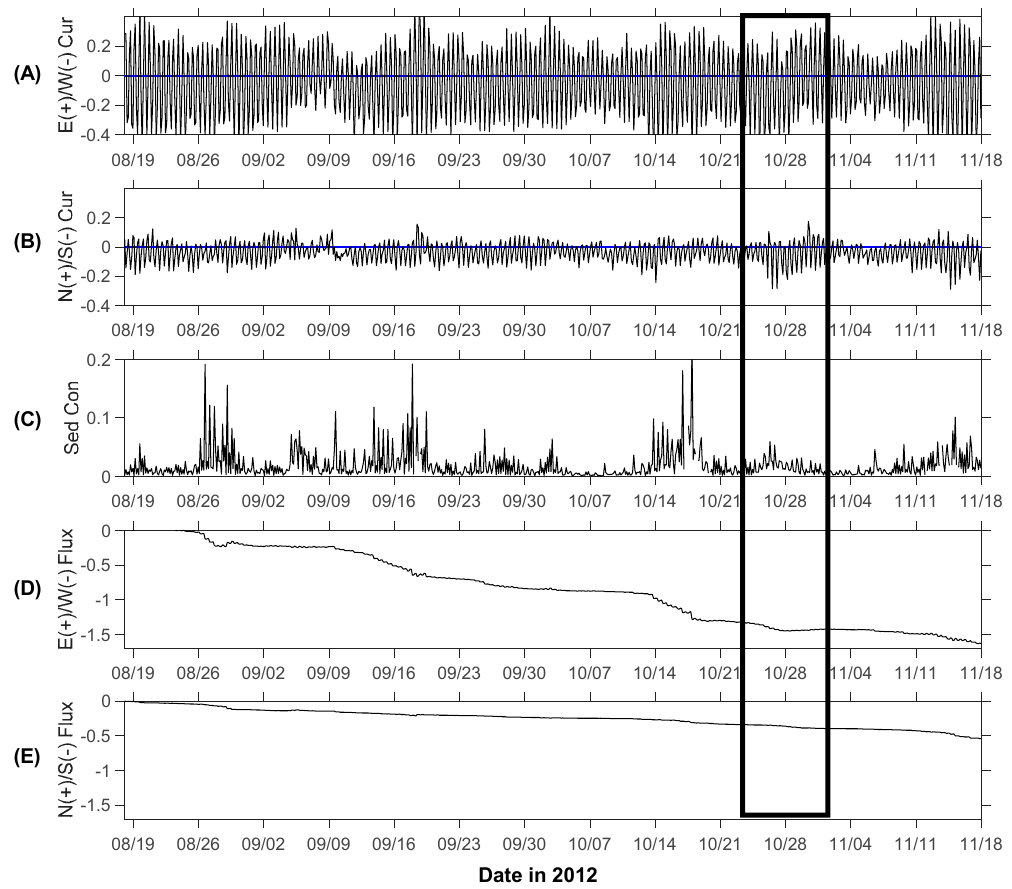
Figure 9. ( A ) East( + ) / west( − ) and ( B ) north( + ) / south( − ) currents in m s − 1 from PCADP data at 0.7 m above bed collected at R1 in fall 2012 between 18 August to 17 November 2012. ( C ) Sediment concentration in kg m − 3 from ABS data at 0.7 m above bed collected at R1 in fall 2012. ( D ) East( + ) / west( − ) and ( E ) north( + ) / south( − ) cumulative sediment fluxes in kg m − 2 s − 1 at R1 in fall 2012.. The rectangle highlights the passing of Hurricane Sandy in late October 2012.